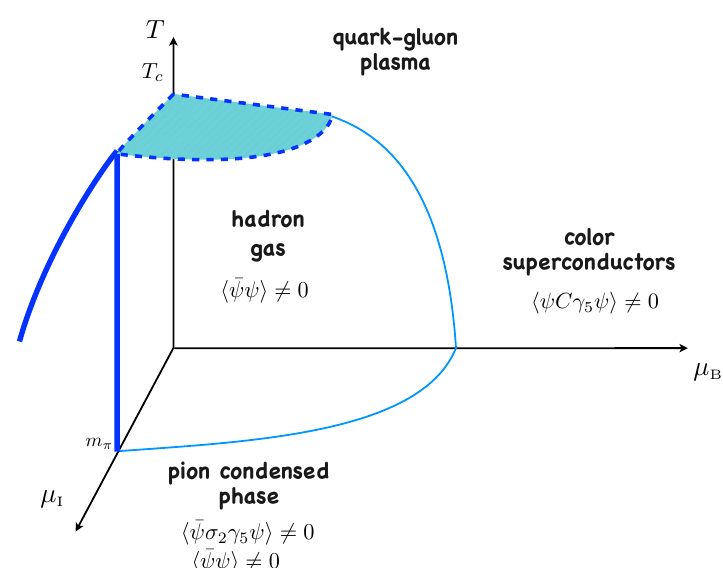
Figure 10. Sketch of the phase diagram of hadronic matter. The solid thick lines have been determined in the LQCD simulations of [133]. For µ B = 0 and T (cid:46) 150 MeV, the transition to the pion condensed phase happens at µ I = m π . The shaded area on the top corresponds to a chiral and deconfinement crossover. We have indicated with thin blue lines the possible transitions from the hadron gas phase to the color superconducting and to the pion condensed phases, although there are neither experimental data nor LQCD simulations that support their existence. How the color superconducting phase turns in a quark-gluon plasma or in a pion condensed phase is not